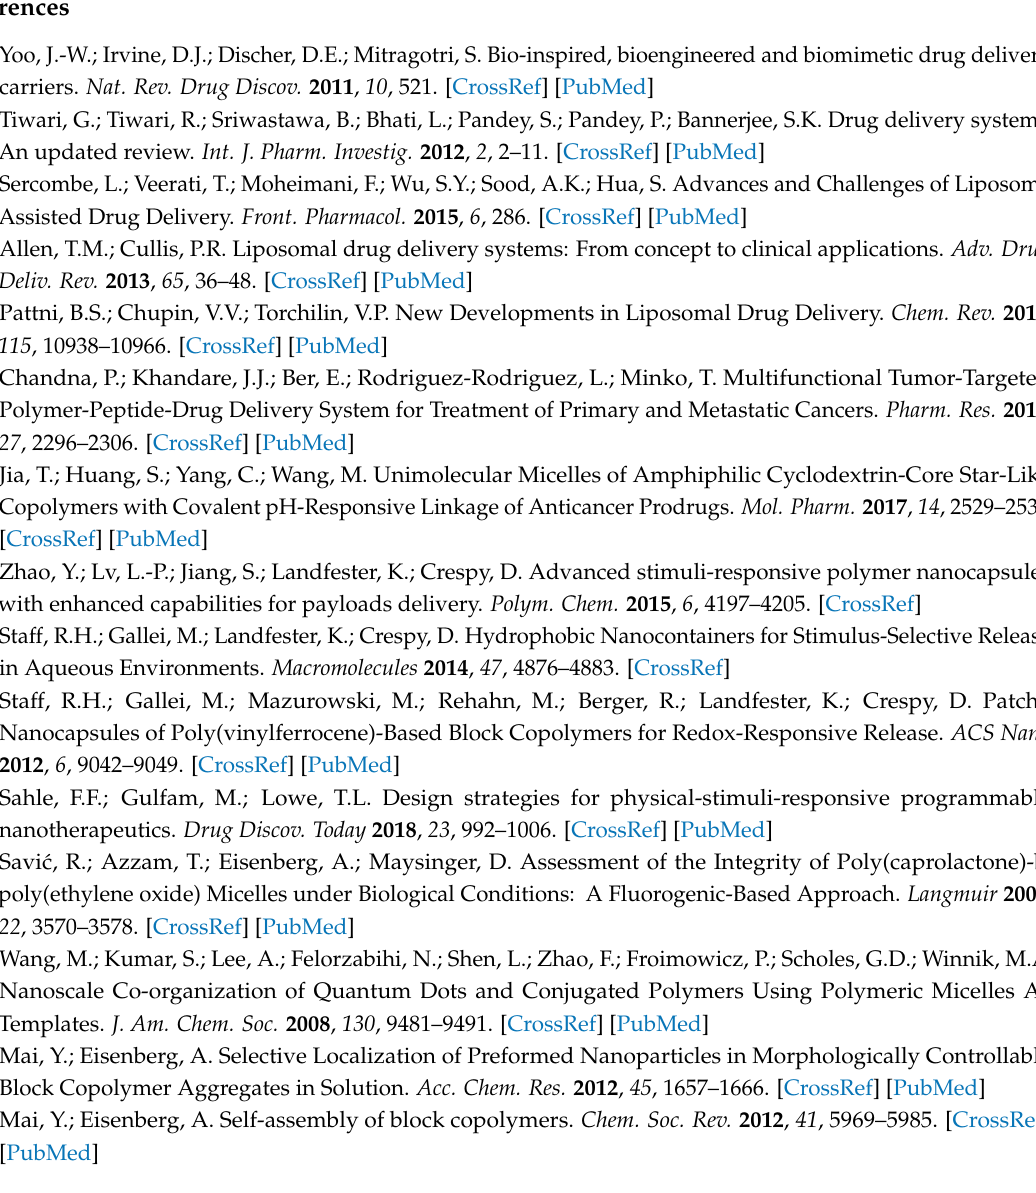
Figure S3: (a) GPC traces of RPO-1, (b) RPO-2 and (c) RPO-3. Figure S4: A representative high-magnification TEM image of RPO-1 micellar structures prepared by Method 1. Figure S5: A representative high-magnification TEM image of RPO-1 micellar structures prepared by Method 3. Figure S6: A representative high-magnification TEM image of RPO-1 self-assemblies prepared by Method 4. Figure S7. A representative high-magnification TEM image of RPO-2 self-assemblies prepared by Method 4. Figure S8. Representative low-magnification (a) and high-magnification (b) TEM images of RPO-3 self-assemblies prepared by Method 4. Figure S9. Fluorescence images of HeLa cells after being incubated with blank RPO-3 micelles over 2